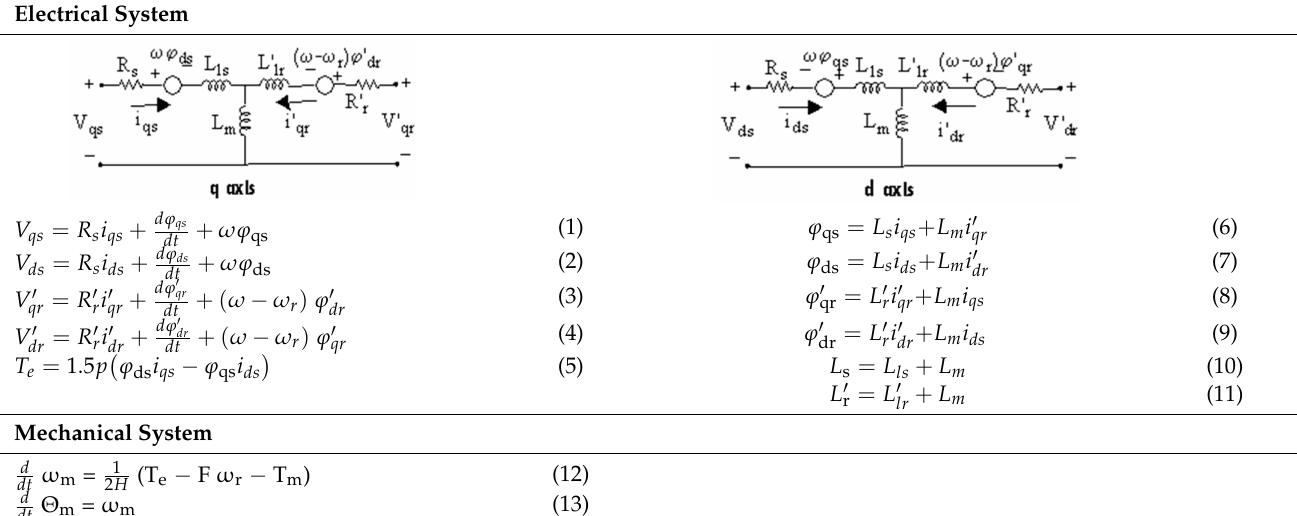
Table 1. Equivalent circuits and equations involved in a DFIG conversion.